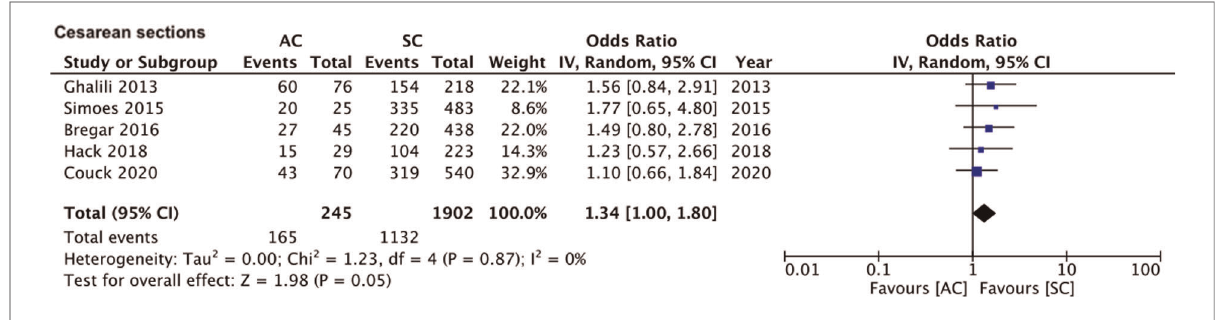
FIGURE 3 Meta-analysis of cesarean sections between assisted and spontaneously conceived monochorionic twin pregnancies.